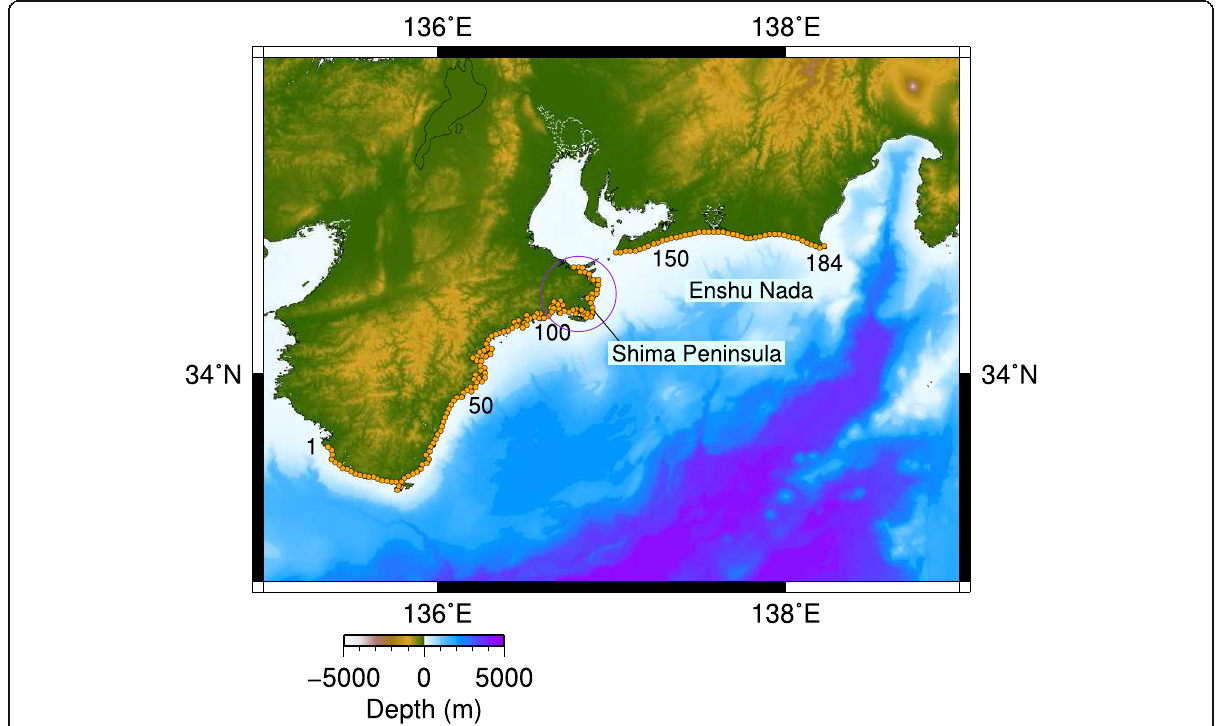
Fig. 4 Locations of the theoretical near-shore tsunami observation sites. Orange circles with station numbers aside are the sites at which simulated tsunami amplitudes and arrival times were